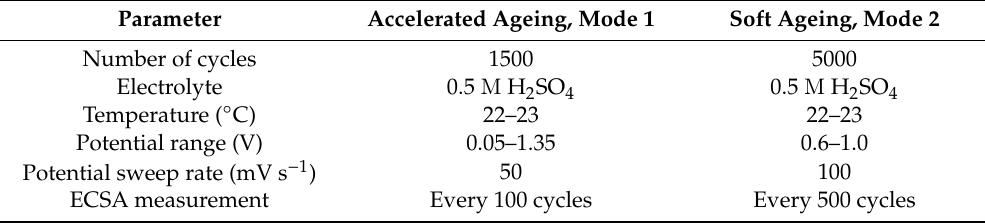
Table 1. Experimental conditions for evaluation of the operation stability of the Pt / C catalysts during cycling. The electrochemically active surface area (ECSA) during cycling was calculated using the H UPD